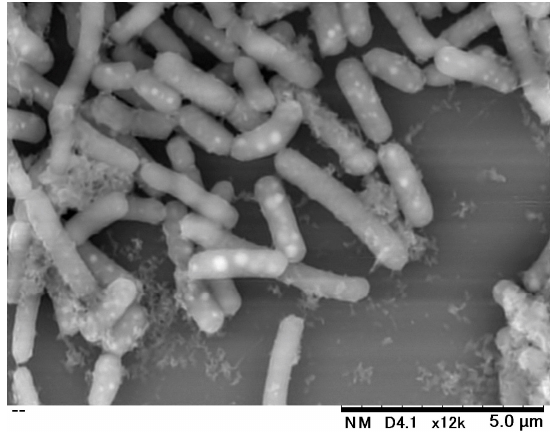
Figure 6. Scanning electron microscopic image of the Lb. paracasei IJH-SONE68 cells.